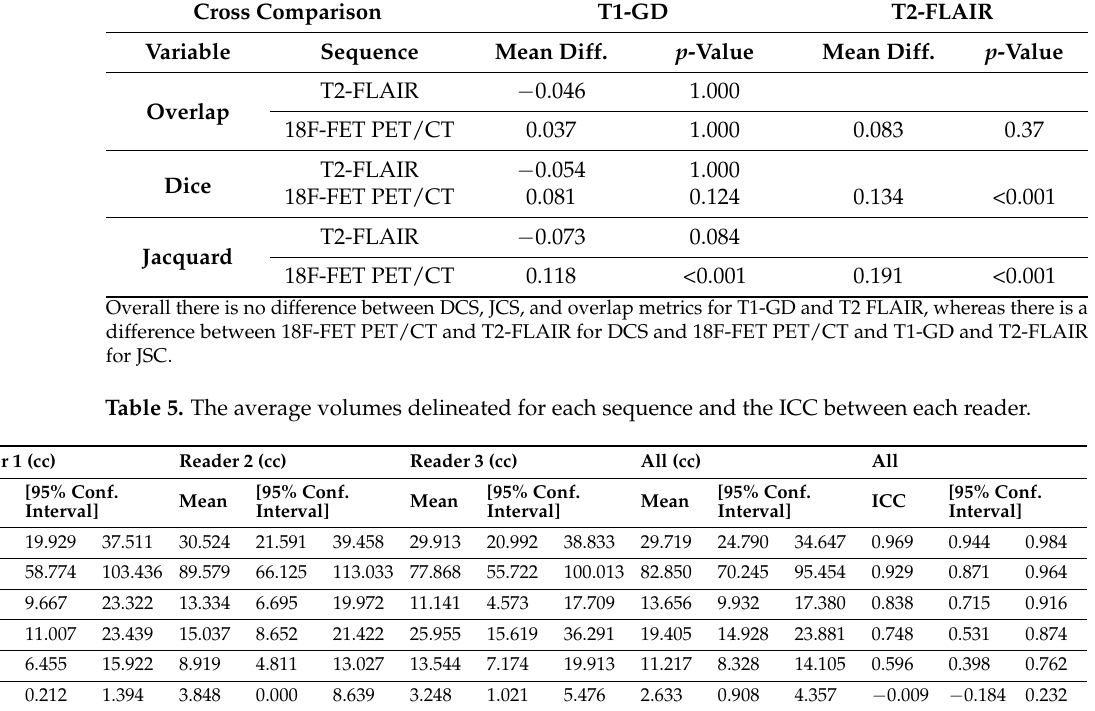
Table 4. Cross comparison between DCS, JSC, and overlap for each sequence. Cross Comparison T1-GD T2-FLAIR Variable Sequence Mean Diff. Mean Diff.